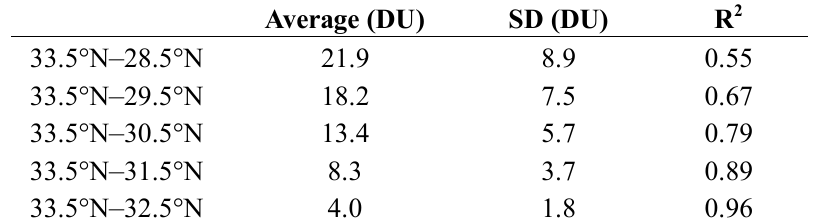
Table 1. Statistical parameters of TOC differences between the northernmost latitude (33.5°N) and other bands for the period 1978–2013 in the Yangtze River Delta.